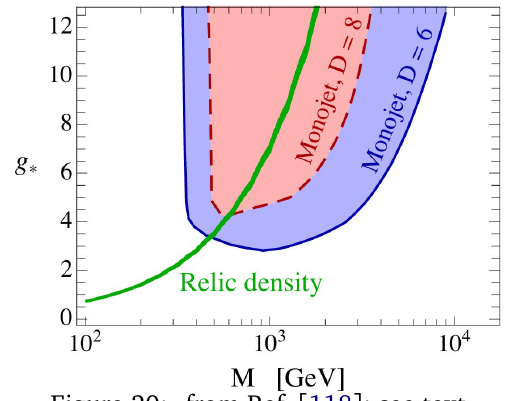
Figure 20: from Ref. [ 118 ] ;